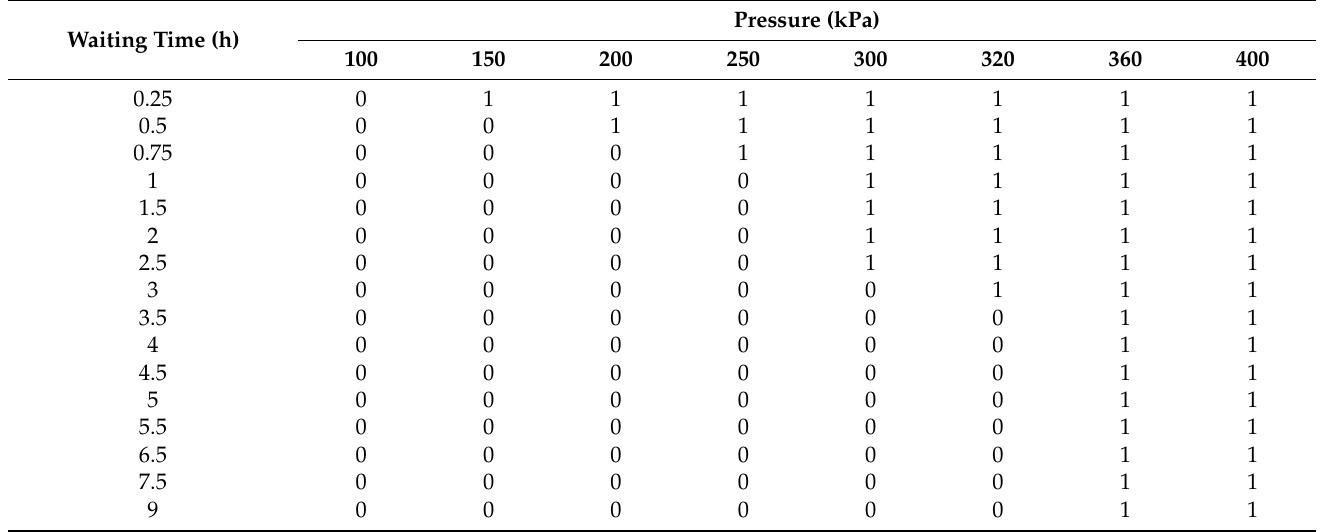
Table 3. Experimental data on the minimum required printing pressure at different levels of waiting time.